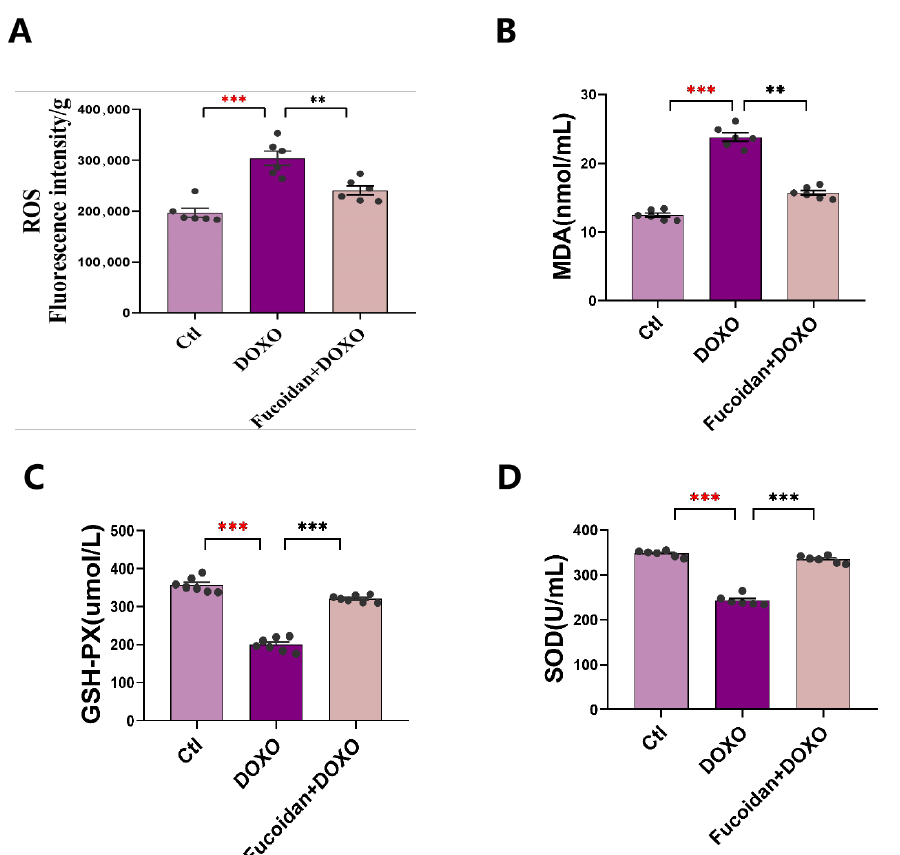
Figure 4. Fucoidan has a significant effect on reducing oxidative stress in DOXO-treated mice. ( A ) Levels of ROS in the mice heart tissues. ( B ) Levels of MDA in the mice serum. ( C ) Content of GSH-PX in the mice serum. ( D ) Content of SOD in the mice serum. n = 6 in each group. ** p < 0.05, *** p < 0.001. The red asterisk is used to indicate the difference between the DOXO group and the Ctl group, and the black asterisk is used to indicate the difference between the DOXO group and the Fucoidan + DOXO group.